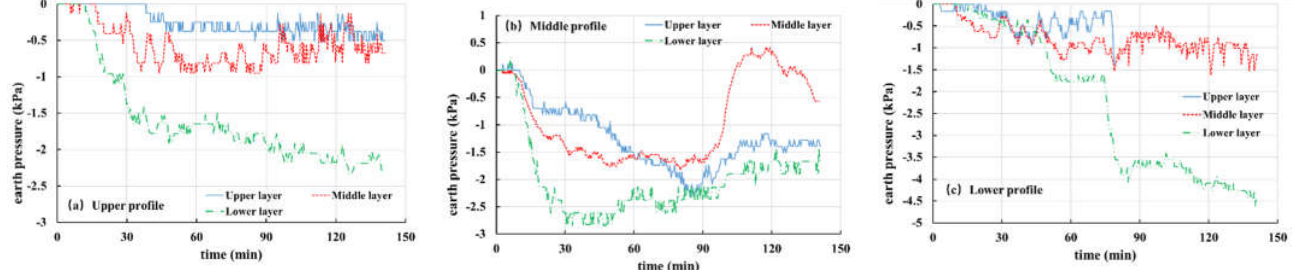
Figure 15. Curves of earth pressure in Test 2 (20 mm, 60 mm/h): ( a ) upper profile; ( b ) middle profile; ( c ) lower profile.